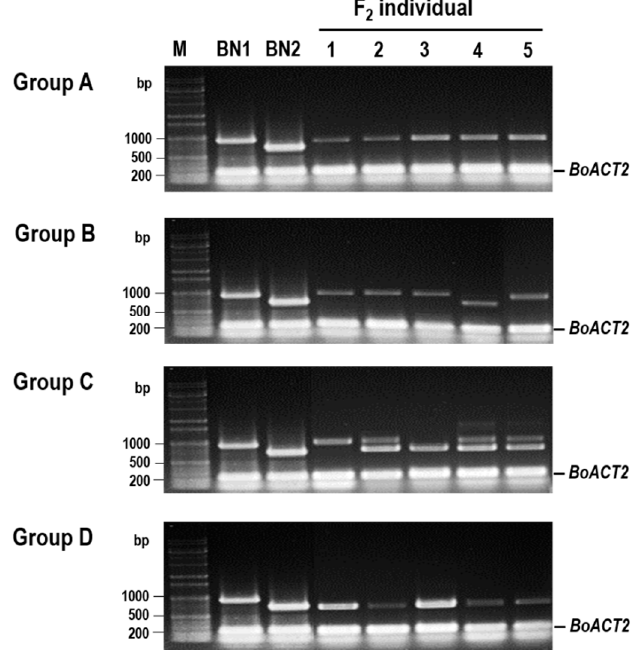
Figure 8. Marker validation using five individuals selected from the segregating F derived from the BN1 × BN2 cross. Groups A to D were the same as those shown in Figure 2C. Five individuals in each group were selected on the basis of leaf